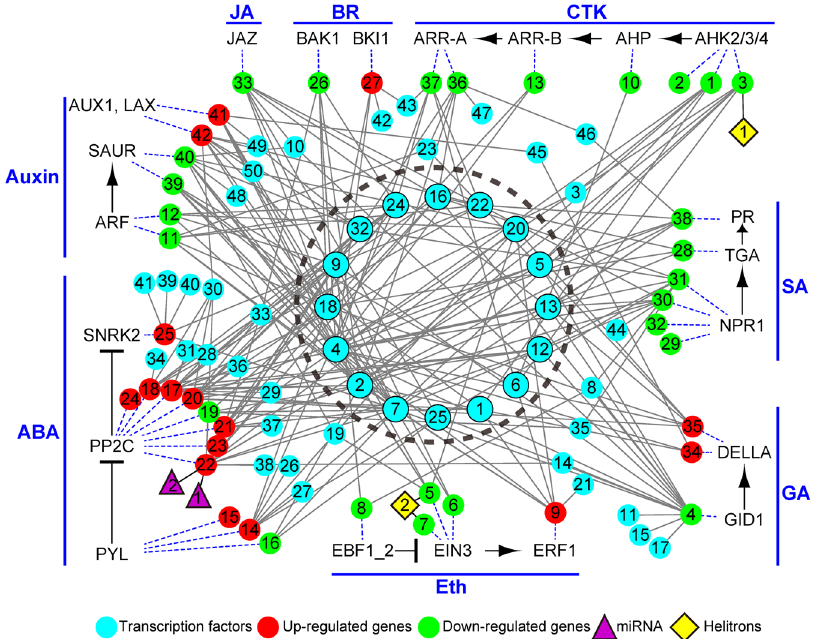
Figure 7. Integrated hormone signal pathway network of P . euphratica after salt stress. Cyan nodes, TFs; red nodes, up-regulated core genes; green nodes, down-regulated core genes; purple triangle, miRNA; yellow diamond, Helitrons . The 16 TFs in center dashed circle are widely related with multiple hormone signal pathways. Blue dash lines indicate the up- or down-regulated core genes corresponding to the genes in various hormone signal pathways. The detail of genes was shown in Supplementary Table S5.